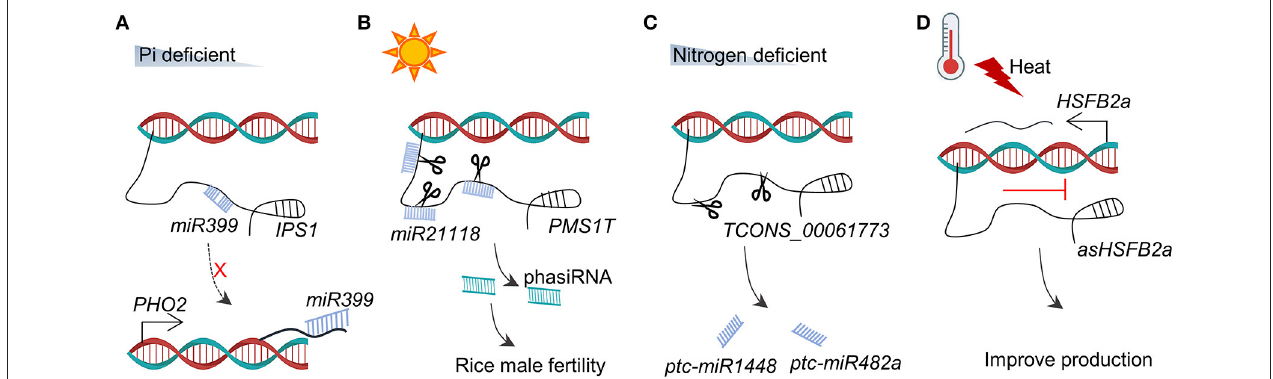
FIGURE 3 | The relationship between lncRNAs and RNAs. (A) Under Pi deficiency, IPS1 serves as an eTM to bind with miR399 , and prevents the interaction between miR399 and PHO2 mRNA. (B) PMS1T is sensitive to photoperiod and is targeted by miR2118 to produce phasiRNA. (C) TCONS_00061773 acts as the precursor of ptc-miR1448 and ptc-miR482a in response to nitrogen deficiency. (D) Heat stress induces asHSFB2a and then represses HSFB2a